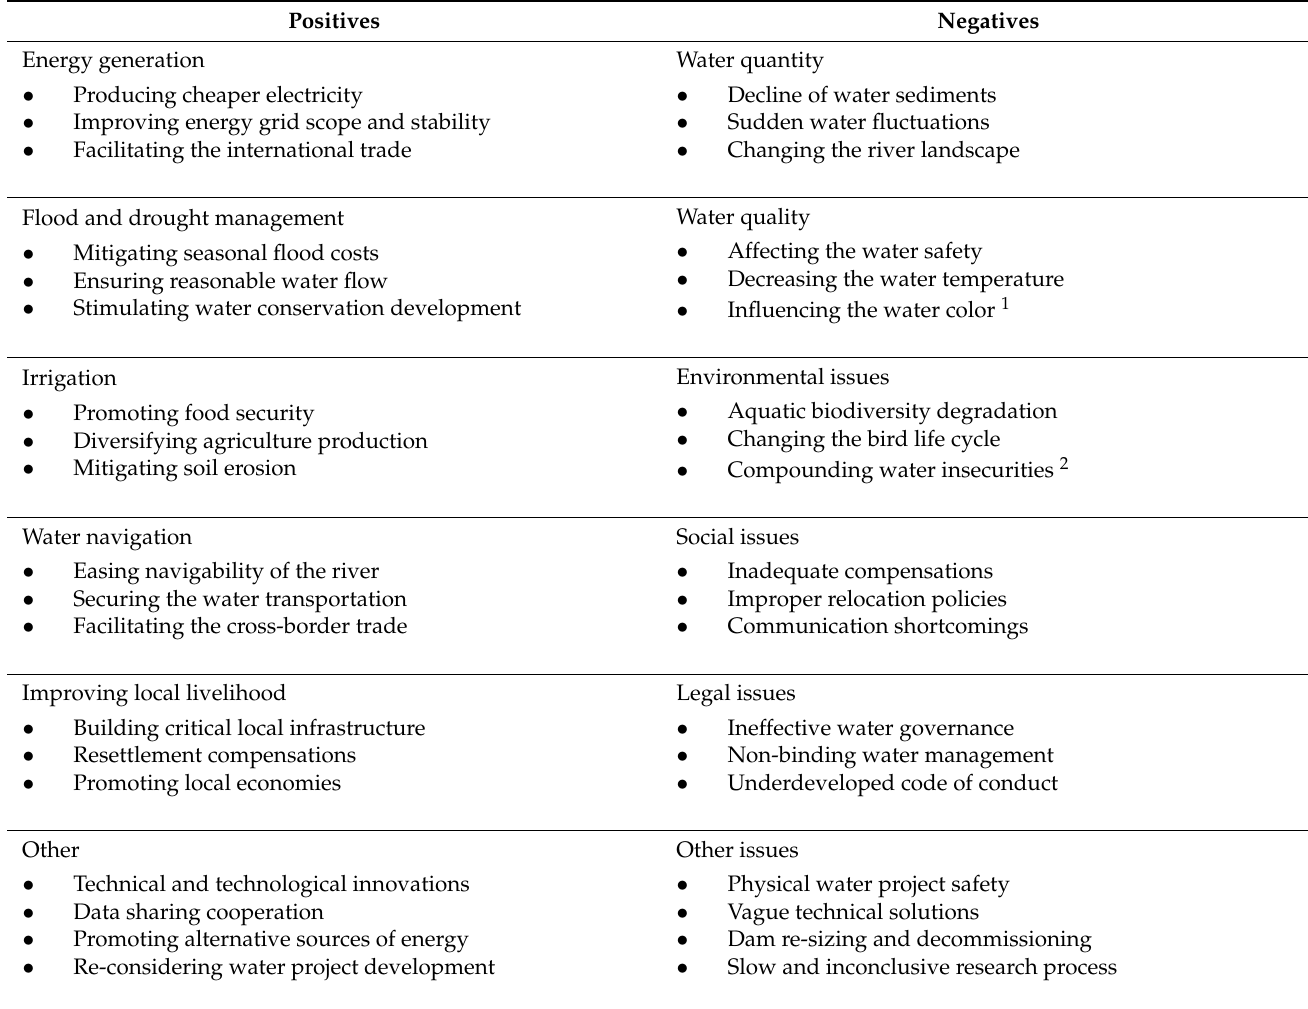
Table 2. Summary of the main consequences of the Lancang-Mekong hydropower